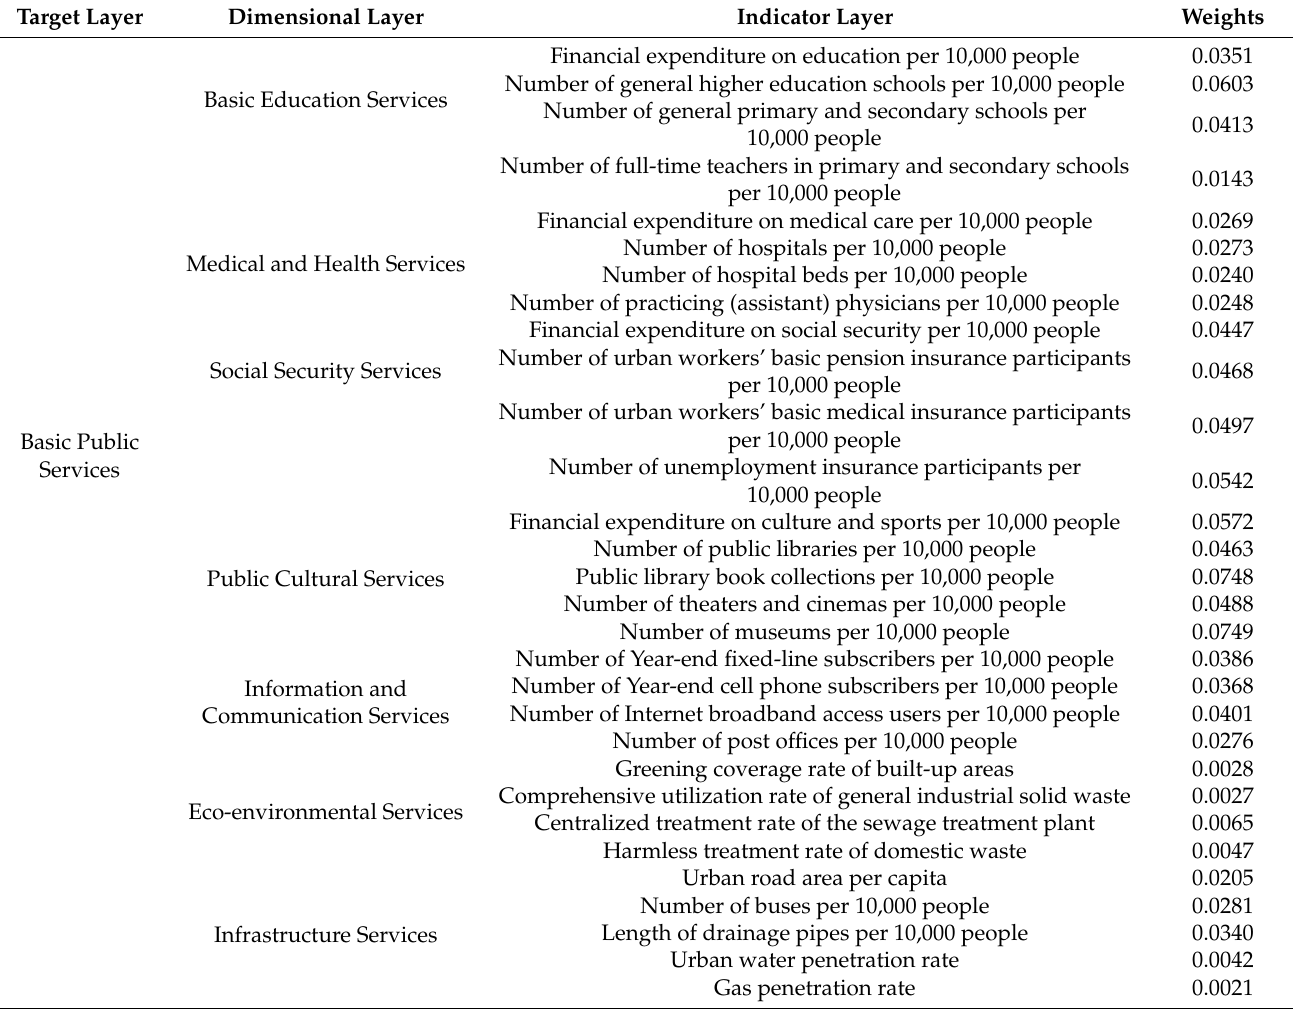
Table 1. The evaluation index system of the